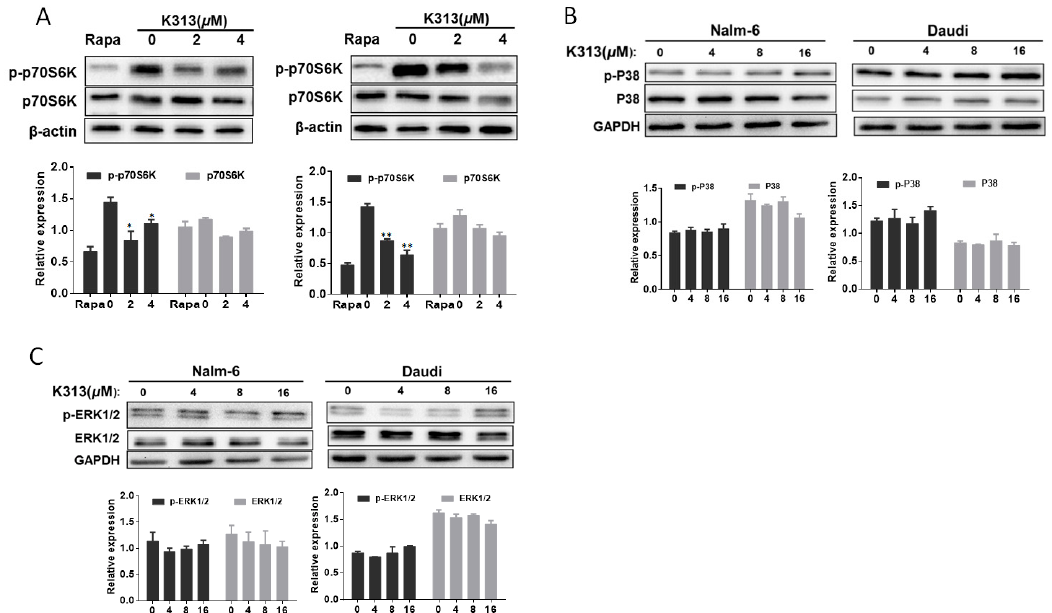
Figure 5. K313 downregulates the phosphorylation of p70S6K in Nalm-6 and Daudi cells. Nalm-6 and Daudi cells were treated with K313 at the indicated concentrations for 12 h. ( A ) Protein levels of p-p70S6K were determined by Western blotting after treatment with K313 or rapamycin. Related protein expression levels were quantified by Quantity One software (Bio-Rad). ( B , C ) Protein levels of p-P38 and p-ERK1 / 2 were analyzed by Western blotting. Related protein expression levels were quantified by Quantity One software (Bio-Rad). * p < 0.05 and ** p < 0.01 vs. control group.